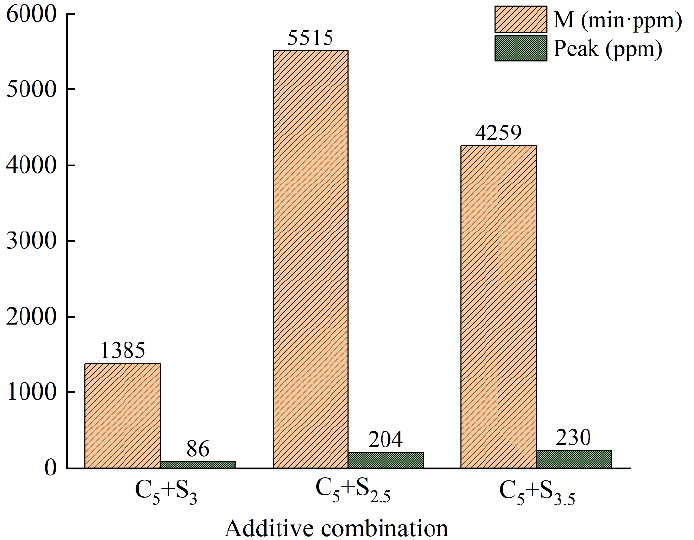
Figure 9. VOCs emission M and peak value P of environmentally friendly modified asphalt under different surfactant contents.